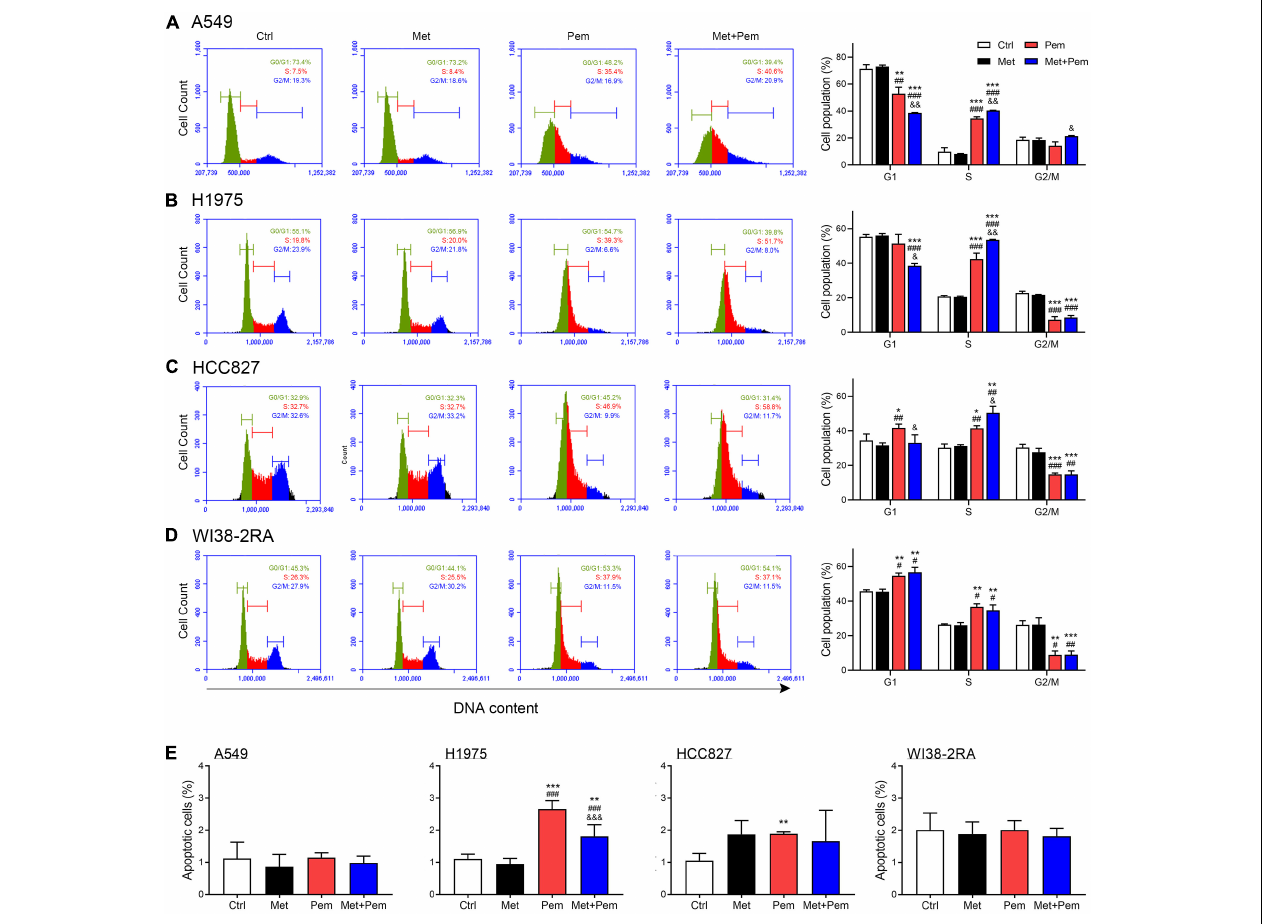
FIGURE 2 | Additive cell cycle arrest and apoptosis effects of metformin and pemetrexed on the NSCLC and normal lung cell lines. Flow cytometric analysis and the cell cycle distribution of (A) A549, (B) H1975, (C) HCC827, and (D) WI38-2RA cells treated with metformin (0.2 mM) and/or pemetrexed (1 µ M) for 48 h. ( A–D , right panel) Quantification of cell cycle distribution. (E) Cytotoxicity of A549, H1975, HCC827, and WI38-2RA treated with the indicated concentration of metformin and/or pemetrexed for 48 h as assessed by flow cytometric analysis with Annexin V/propidium iodide (PI) staining. Percentages of Annexin V-positive cells (apoptosis cells population) are shown. The data are presented as the mean ± SD of those from three independent experiments with three technical replicates in each. * P < 0.05, ** P < 0.01, and *** P < 0.001 compared with the Ctrl group; # P < 0.05, ## P < 0.01, and ### P < 0.001 compared with the Met group; & P < 0.05, && P < 0.01, and &&& P < 0.001 compared with the Pem